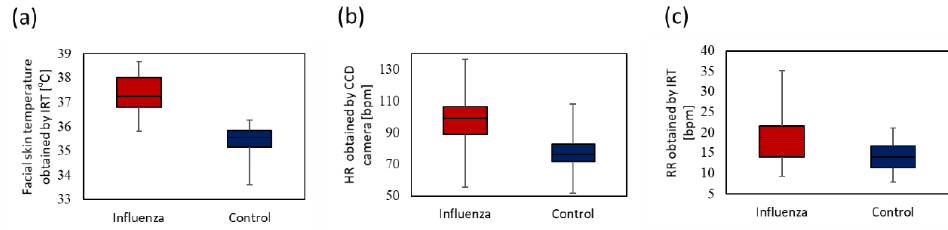
Figure 12. Box plot of vital signs between influenza patients and healthy control subjects. ( a ) Facial skin temperature. ( b ) HR. ( c ) RR.